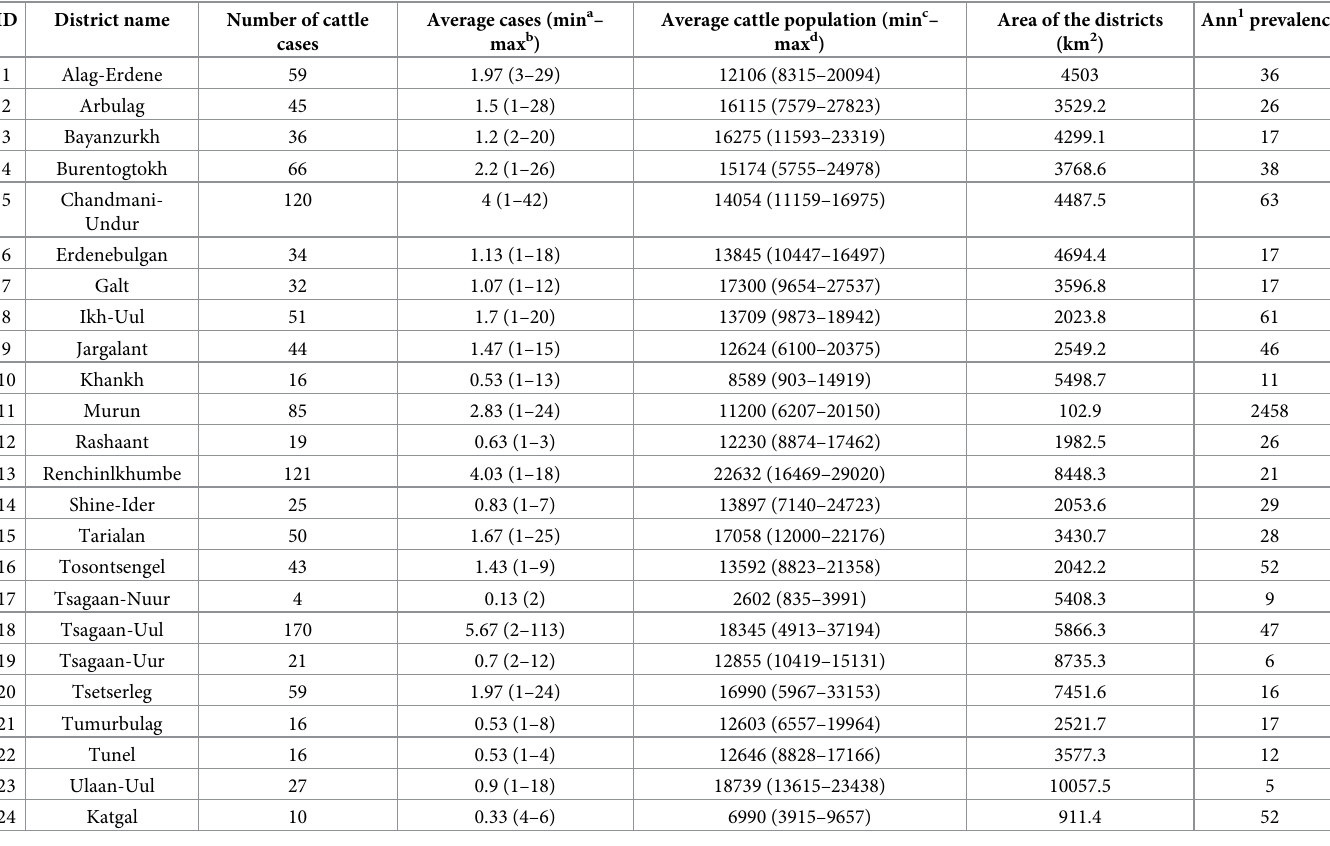
Table 2. Annual cattle anthrax prevalence per 1,000,000 population per 1000 km 2 in Khuvsgul Province by